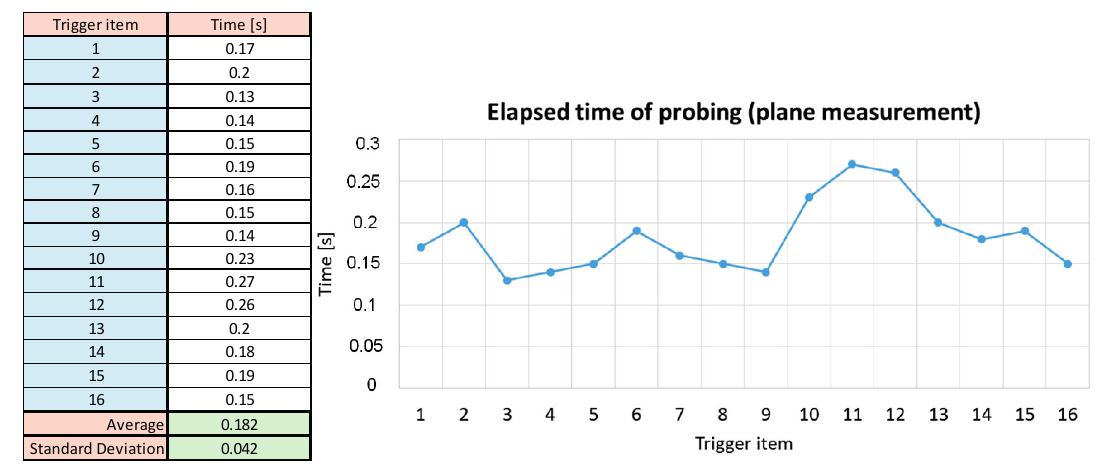
Figure 11. Duration time for triggering